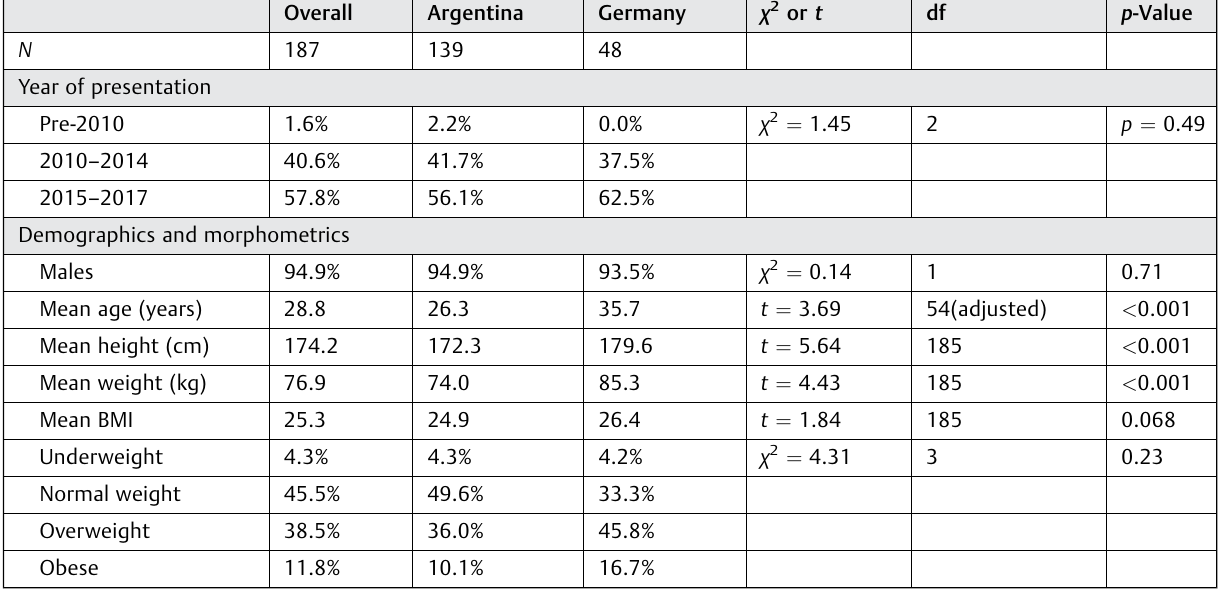
Table 1 Demographics and morphometrics of the sample: overall and by country